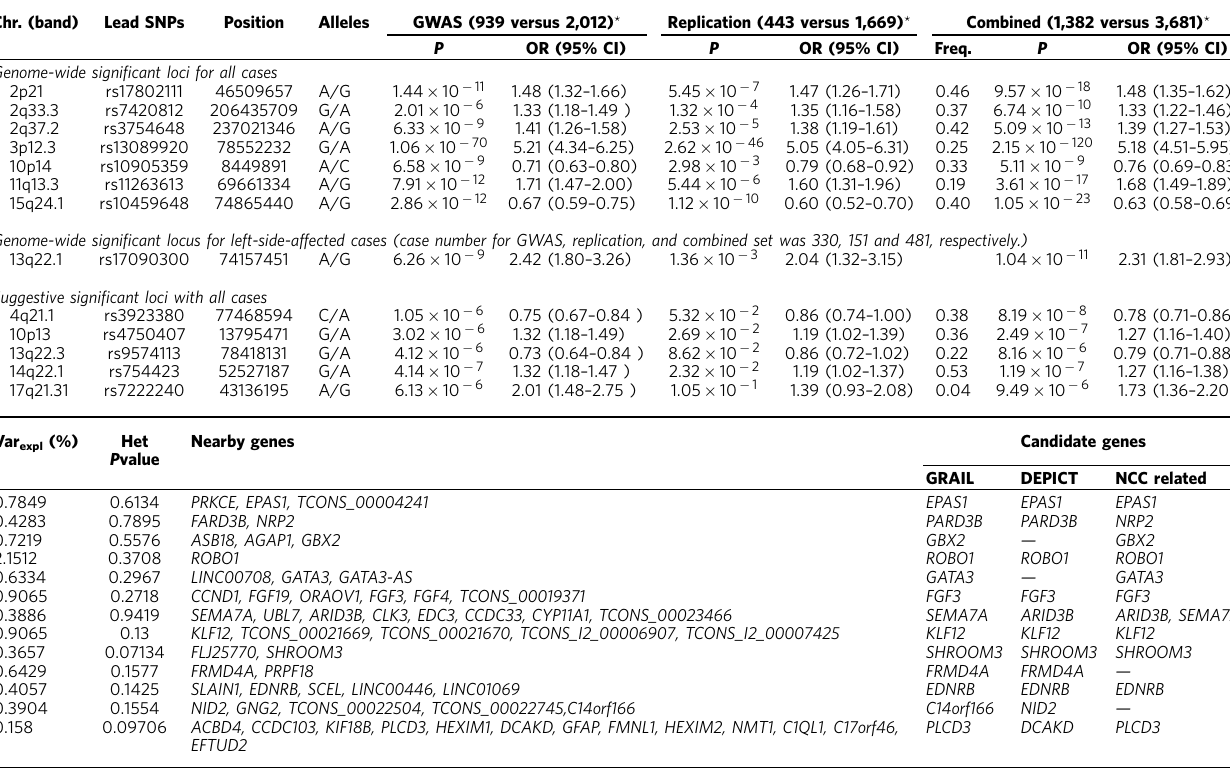
Table 1 | Most significantly associated risk variants with craniofacial microsomia. Chr.